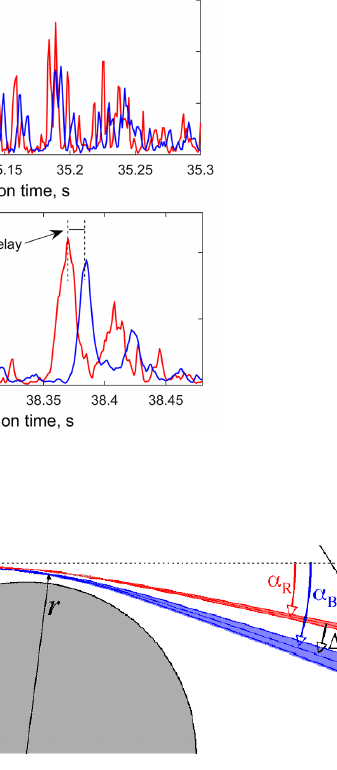
Figure 2. A scheme of chromatic refraction and the principle of re- fraction angle measurement by GOMOS. Both the refraction angles and the effect of dispersion are strongly exaggerated. However, the width of each beam relative to the angle difference (cid:49)α is realistic. The impact parameter p is the geometric distance of the ray from the Earth’s center. The vertical separation of blue and red rays at the ray perigee of 30km is ∼ 10m (Dalaudier et al.,